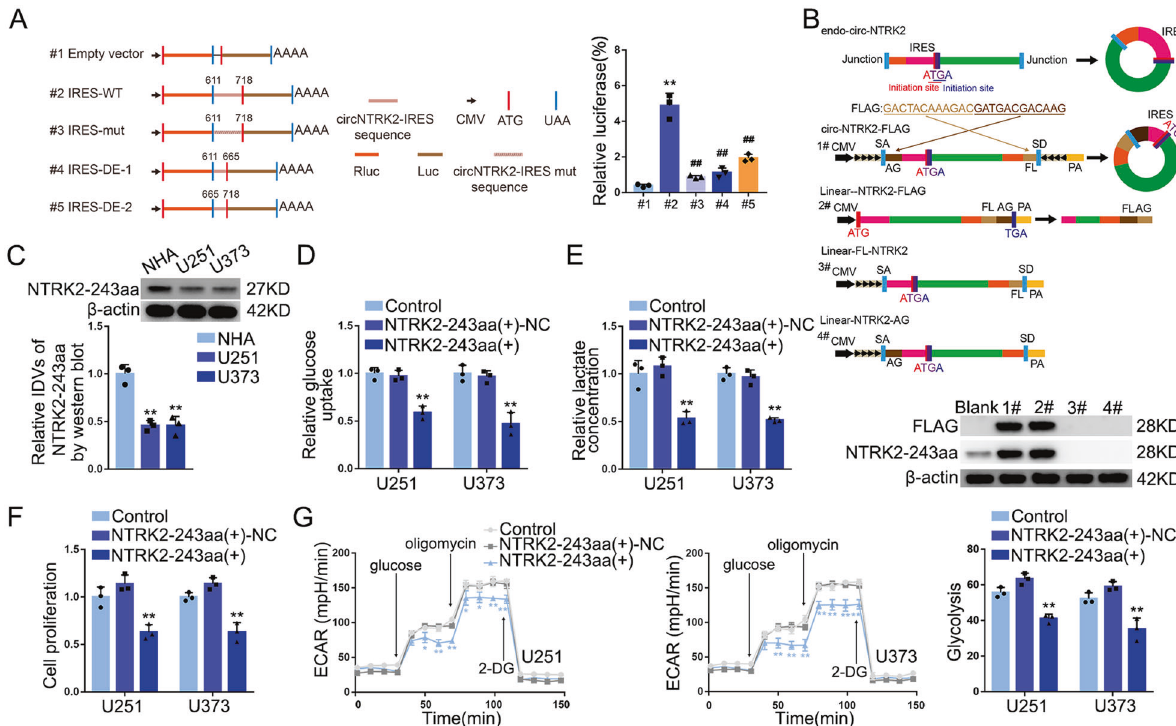
Fig. 4 NTRK2-243aa, encoded by CircNTRK2, inhibited glycolysis and proliferation of GBM cells. A The activity of IRES (611 – 718) in circNTRK2 was tested. Left panel shows circNTRK2 IRES (611 – 718) wild type, mutant type, and two truncated types were cloned between Luc and Rluc with independent promoter and terminator on both sides respectively. Right panel shows Dual-Luciferase Reporter Assay kit determined Luc/Rluc relative luciferase activity in HEK-293T cells transfected with vectors on the left. Data are presented as mean ± SD ( n = 3, each group). ** P < 0.01 compared with empty vector group. ## P < 0.01 compared with IRES (611 – 718) WT group. B The coding ability of ORF in circNTRK2 was tested. Endo-circ-NTRK2: scheme showing how endogenous circNTRK2 formed with circular junction inside the ORF forming